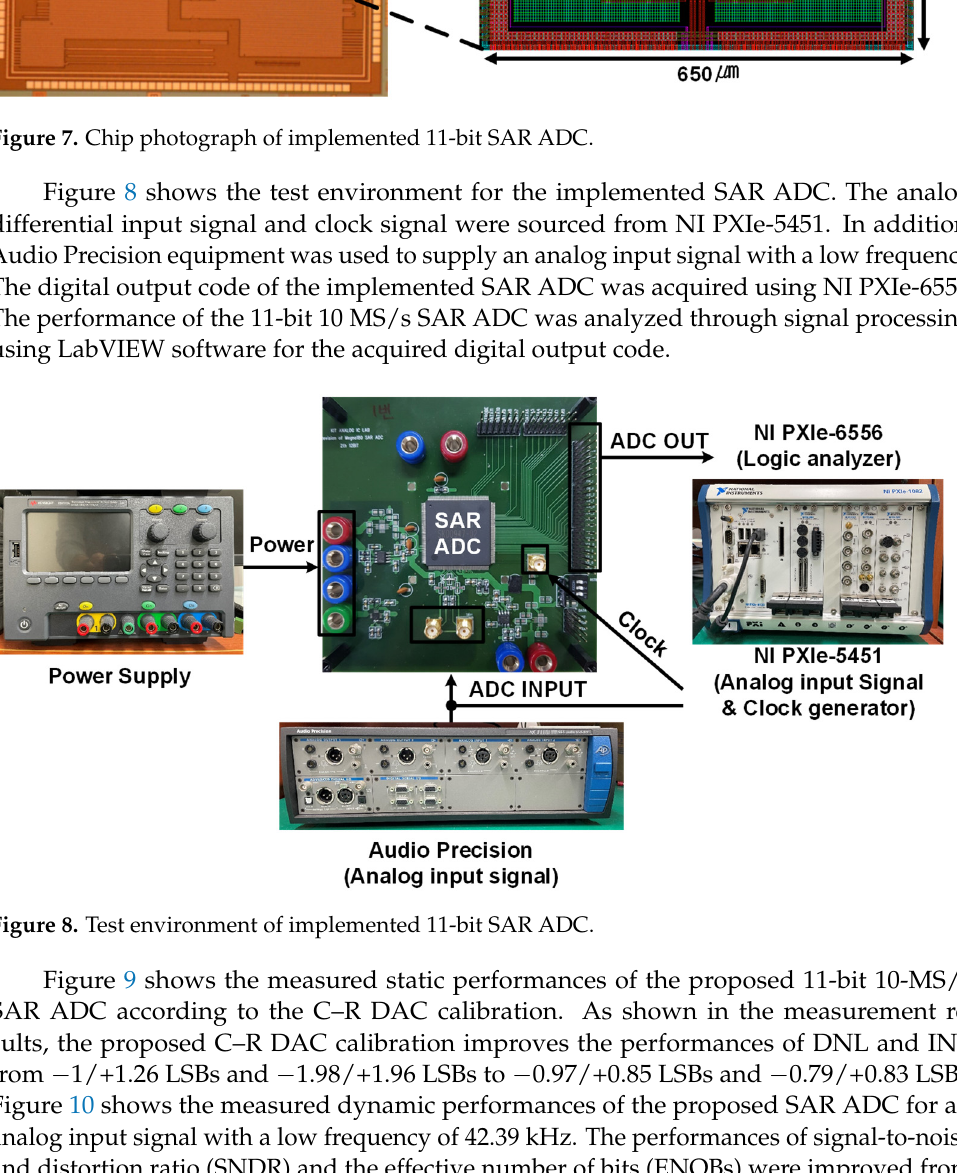
Figure 8. Test environment of implemented 11-bit SAR ADC.